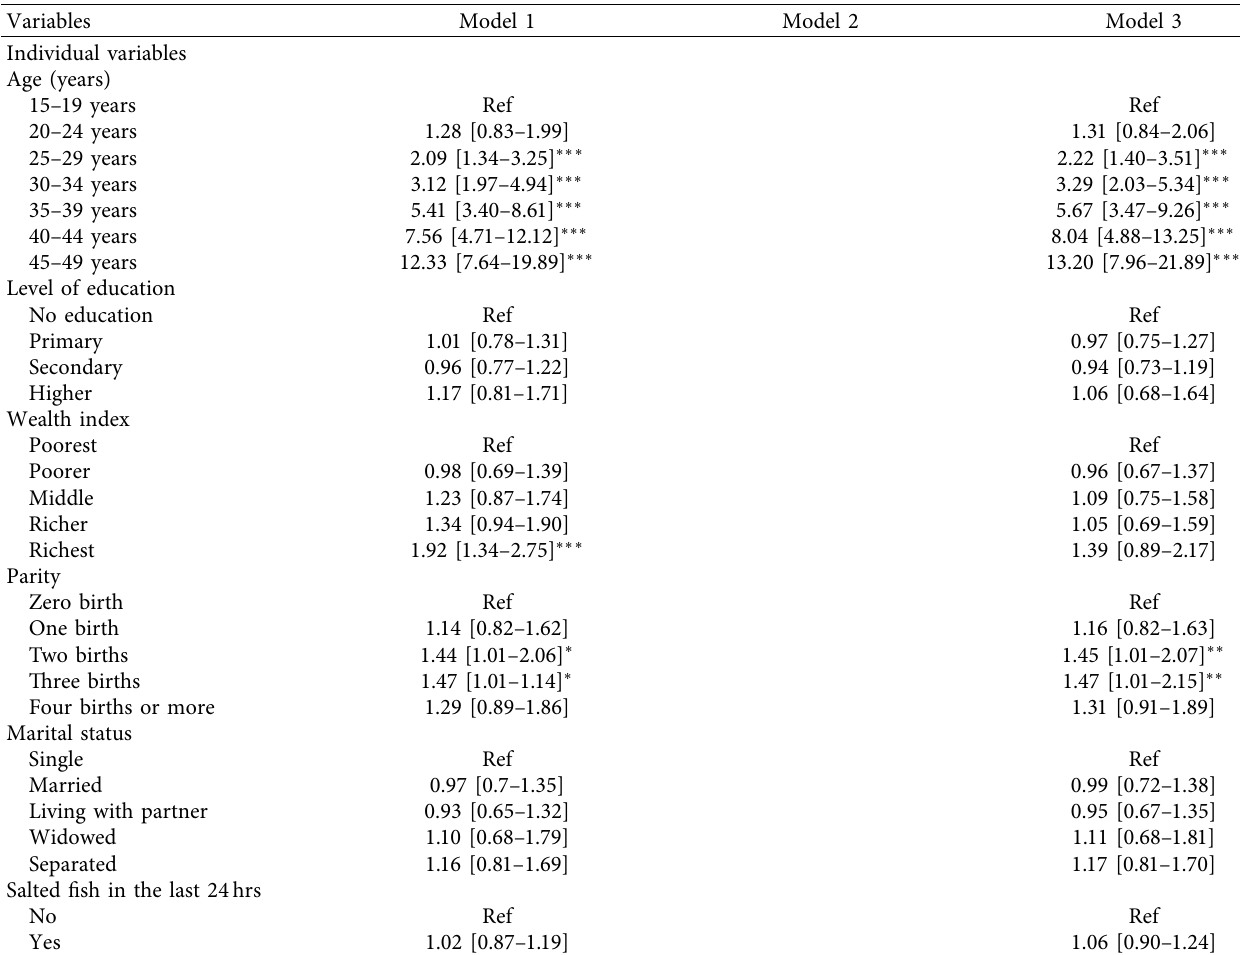
Table 3: Multivariate logistic